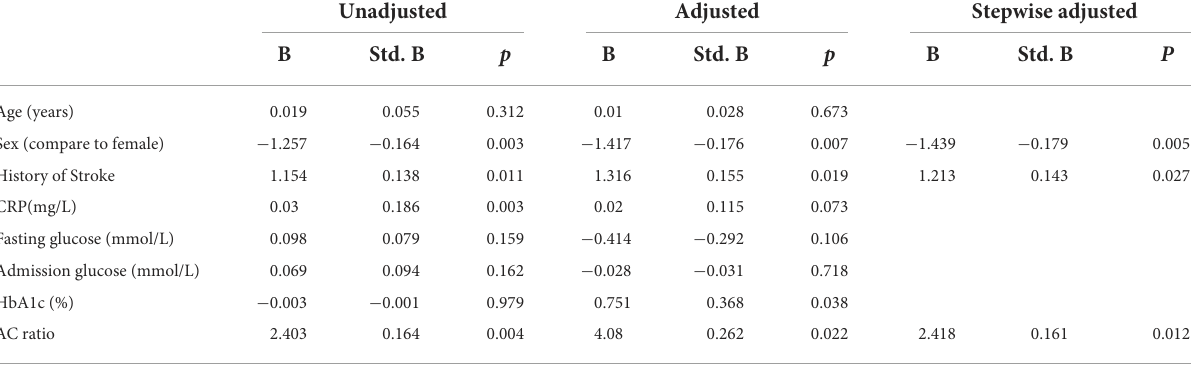
TABLE 2 Regression analysis of admission NIHSS.